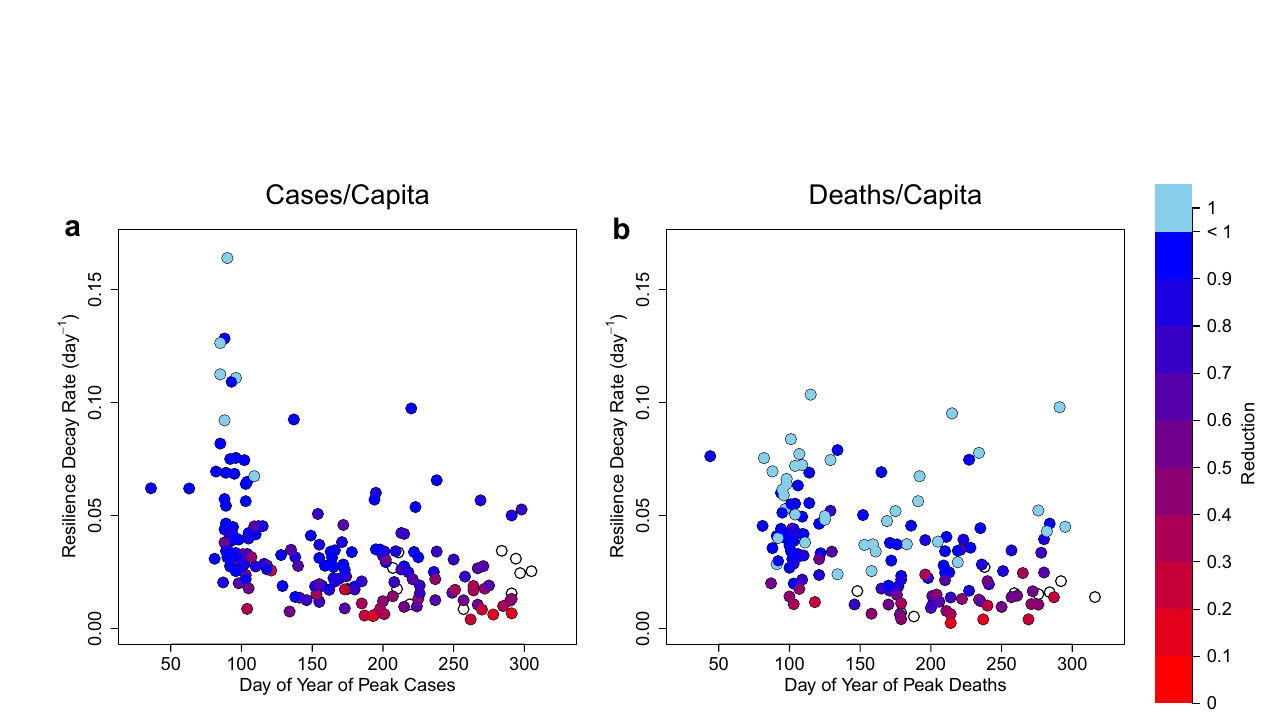
Figure 4. Country-level relationships between timing (day of year) of peak, resilience to COVID-19, and resulting reduction of cases and deaths. ( a ) cases/capita: relationships between day of year of peak cases and resilience (n = 176, ρ =−0.51, p < 0.0001) and between day of year of peak cases and reduction (n = 164, ρ =−0.54, p < 0.0001). ( b ) deaths/capita: relationships between day of year of peak deaths and resilience (n = 157, ρ =−0.43, p < 0.0001) and between day of year of peak deaths and reduction (n = 150, ρ =−0.39, p < 0.0001). Cases of complete reduction—i.e. elimination of cases or deaths—are denoted with pale blue. Cases where reduction is incomplete at the end of the time series are denoted with open